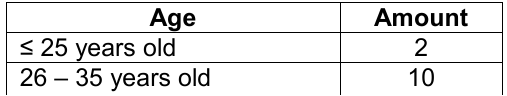
Table 1. The Age and Gender of the